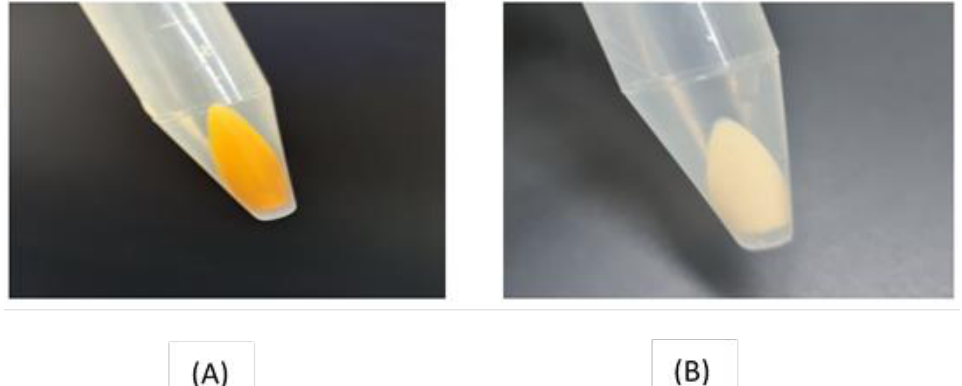
Figure 2. ( A ) Photographed pelleted cells of a pigmented isolate; ( B ) photographed pelleted cells of a non-pigmented isolate.